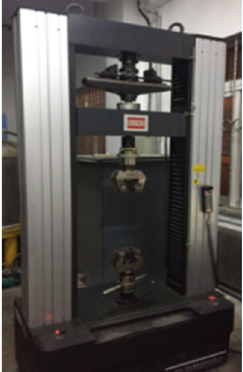
Figure 12: SEM observations of a regular octahedron with di ff erent angles under the same multiples ( a ) Y - axis positive and ( b ) Z - axis positive. Figure 13: UTM5105 electronic universal testing